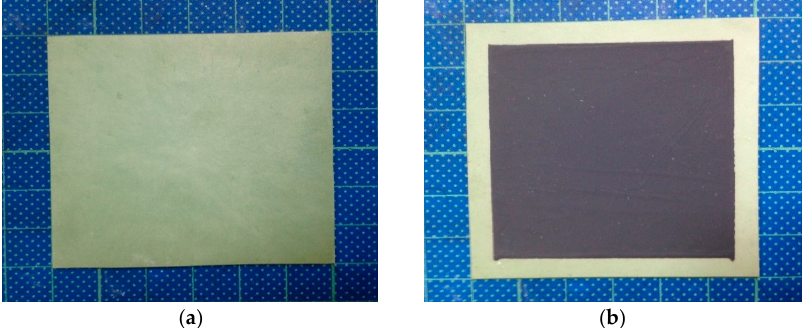
Figure 3. Photograph of the cell unit: ( a ) the anode ‐ supported electrolyte substrate (after sintering) and ( b ) the SOFC cell unit (after sintering).